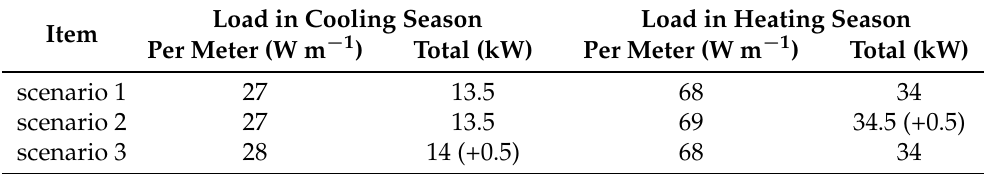
Table 2. Different scenarios of the MSBHE